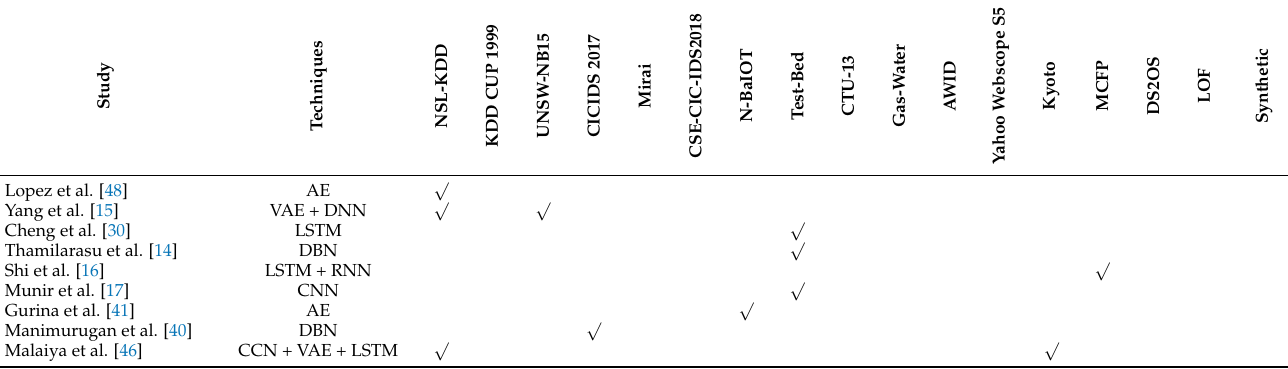
Table 6. The datasets used in the